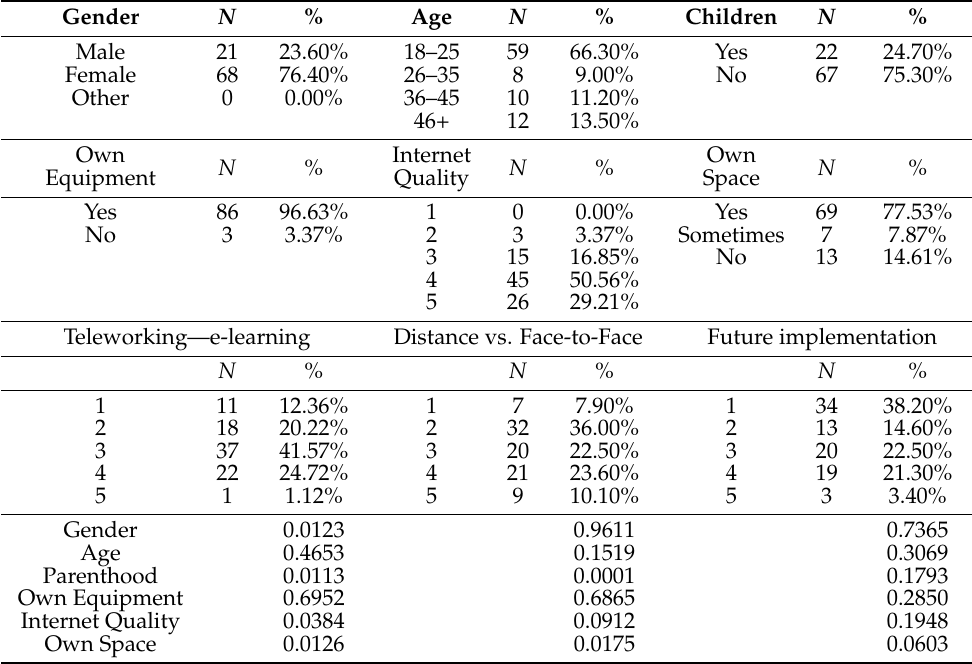
Table 1. Survey answers and p -value ( N =